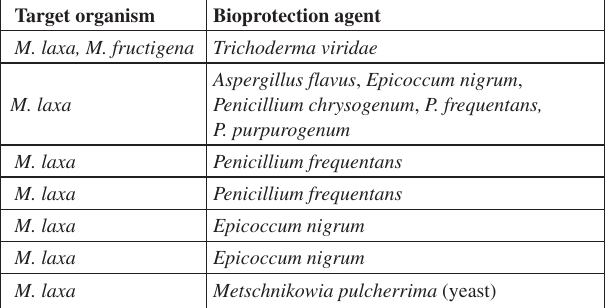
Table 2. Some organisms used in biological control against Monilia